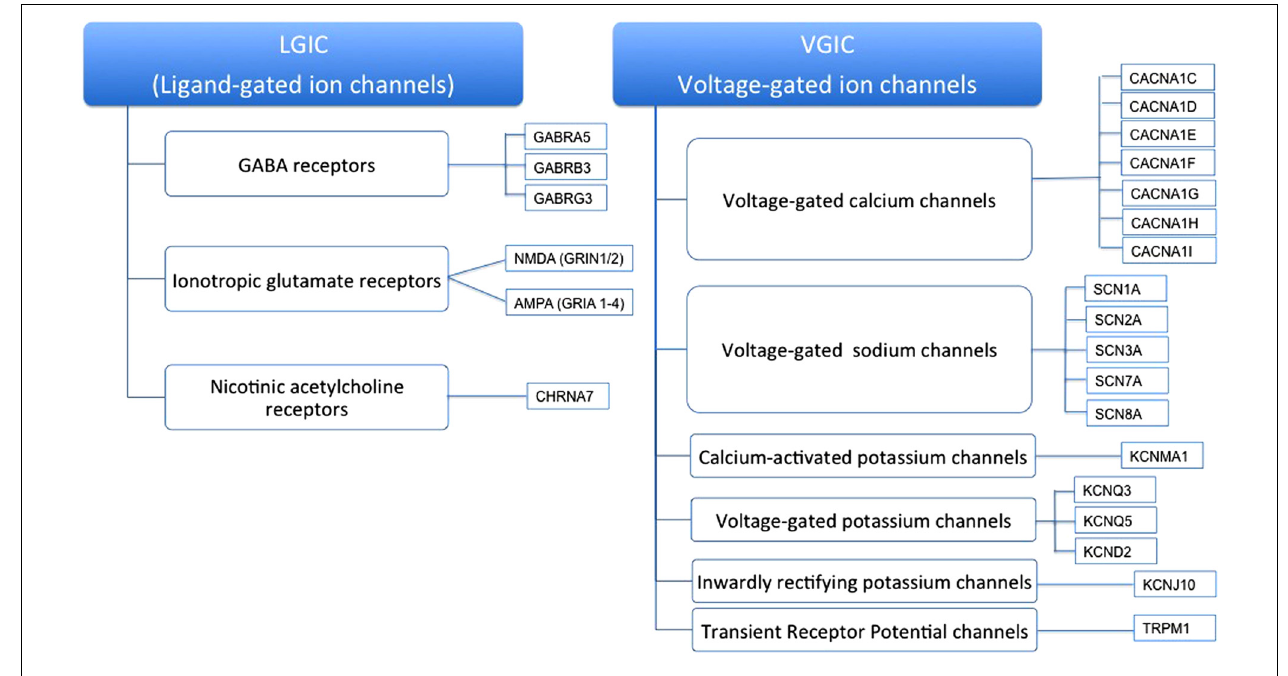
FIGURE 1 | Ion channel families and their mechanism of